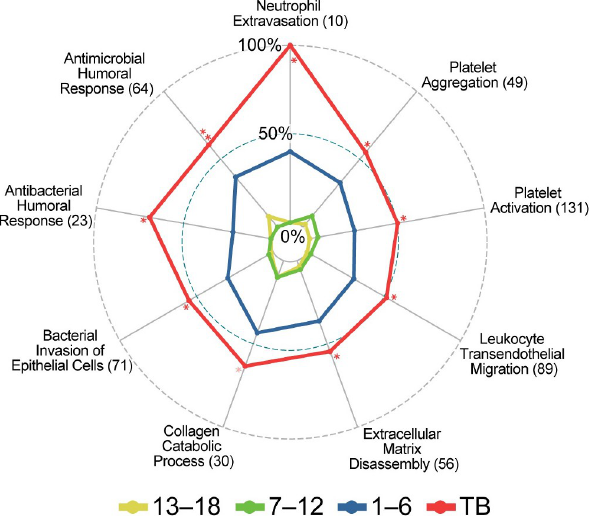
Fig 6. Pathways first enriched in TB patients. Radar plot with symbols as in Fig 2. The full name for “Antimicrobial Humoral Immune Response ... ” is “Antimicrobial humoral immune response mediated by antimicrobial peptide (GO:0061844)”.